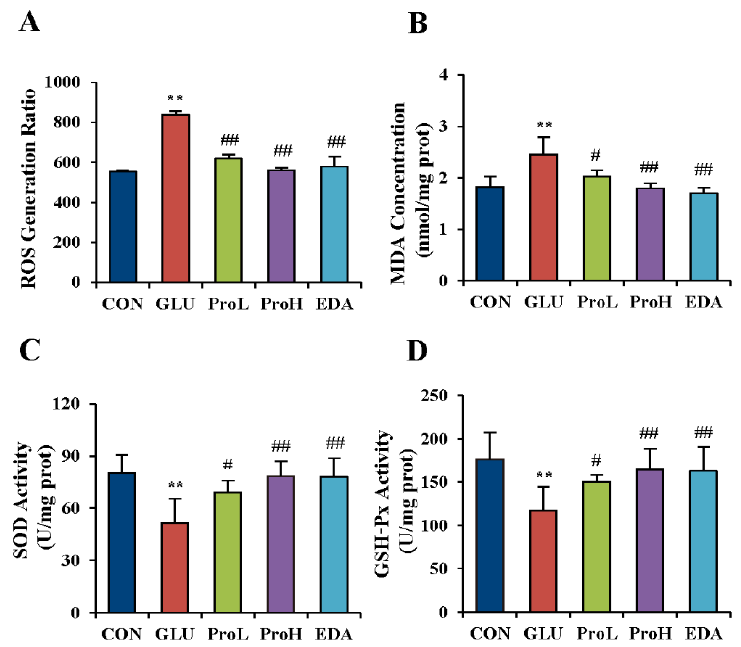
Figure 6. Proanthocyanidins ameliorated the oxidative stress state induced by high glucose in the eye of chick embryo. ROS generation ratio ( A ), MDA level ( B ), SOD ( C ) and GSH-PX ( D ) activities were measured in the eye of EDD 3.5 chick embryos. Values were expressed as mean ± SD in each group (n = 10). ** p < 0.01 vs. control, # p < 0.05, ## p < 0.01 vs. glucose. CON: control, GLU: high glucose, ProL: 1 nmol/egg proanthocyanidins, ProH: 10 nmol/egg proanthocyanidins, EDA: